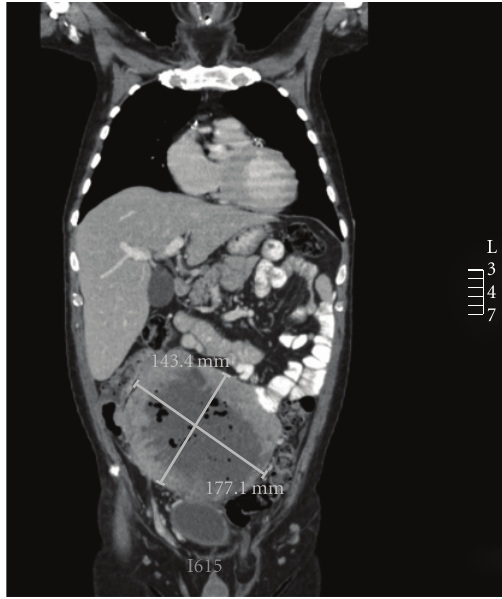
Figure 1: A representative cross-section of the mass on CT scan. The mass was secondarily infected following CT guided biopsy as indicated by the locules of gas within the tumour mass.